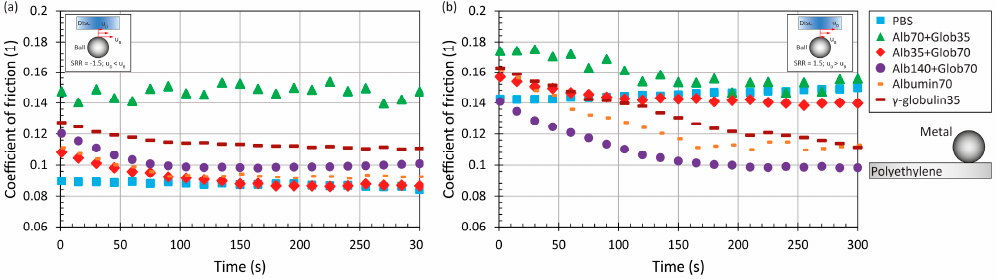
Figure 7. Development of CoF as a function of time for metal-on-polyethylene pair at higher mean speed under negative ( a ) and positive ( b ) sliding conditions for various model fluids.